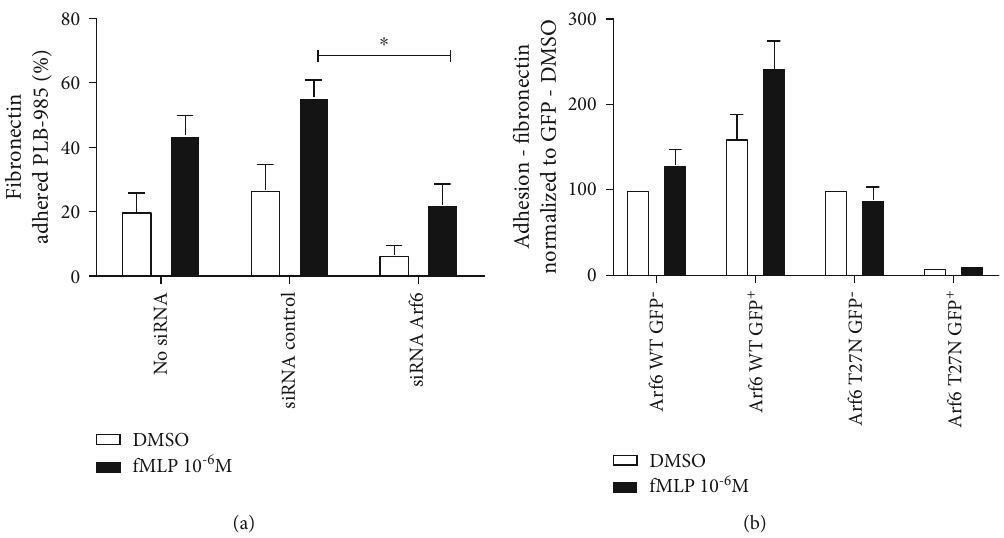
Figure 2: Arf6 regulates fMLP-induced PLB-985 adhesion to immobilized fi bronectin. (a) PMN-like PLB-985 silenced or not for Arf6 (48 h) were labeled with calcein-AM and stimulated with fMLP for 30min to promote adhesion to fi bronectin ( n = 4 independent experiments performed in triplicate). (b) PMN-like PLB-985 were transfected with the various Arf6-GFP constructs for 48h. GFP + /7AAD - and GFP - /7AAD - cells were sorted using GFP setting as previously described [23], and fMLP-mediated adhesion of calcein-labeled PMNs to fi bronectin was evaluated (Arf6 WT GFP - and Arf6 WT GFP + n = 3 ; Arf6 T27N GFP - n = 2 ; Arf6 T27N GFP - n = 1 experiment performed in triplicate). Cell adhesion was evaluated, and data were normalized as described in Materials and